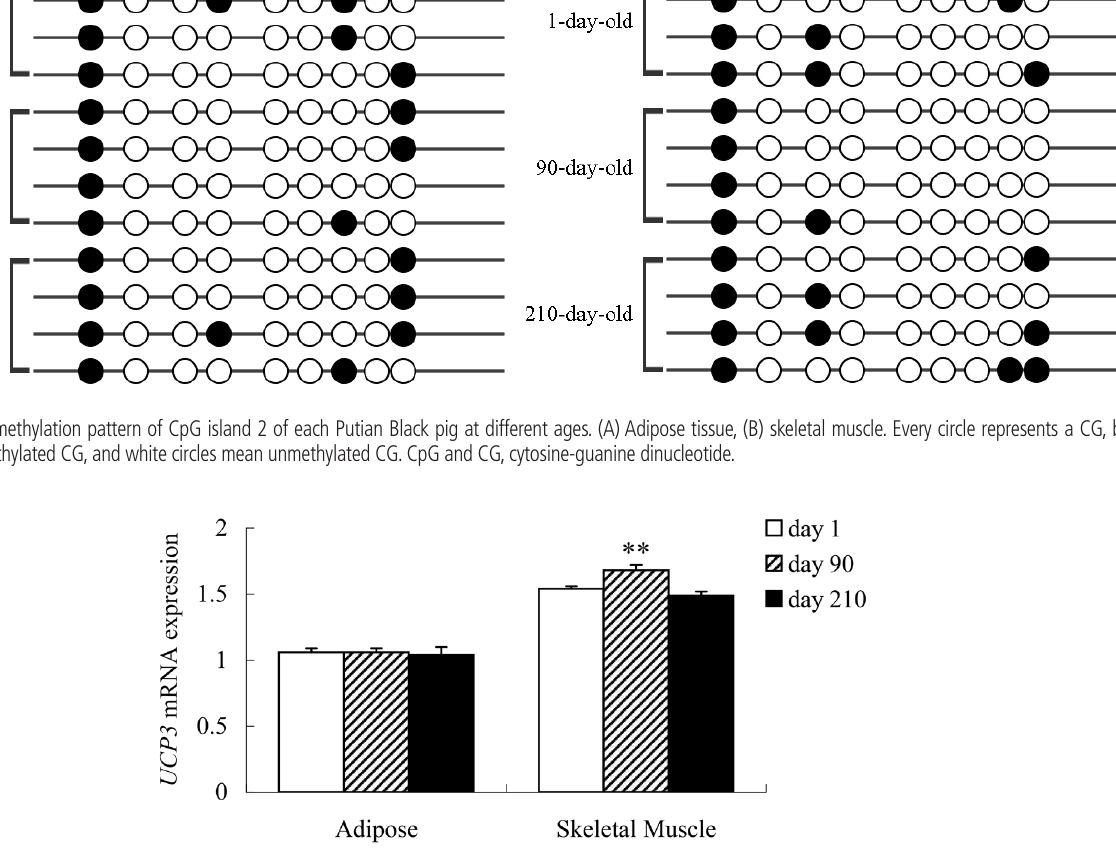
Figure 3. Differentiation of UCP3 mRNA expression in adipose tissue and skeletal muscle between different ages. Values are means with their standard errors. Significant differences between groups in the same tissue are denoted by ** (p<0.01). UCP3, uncoupling protein